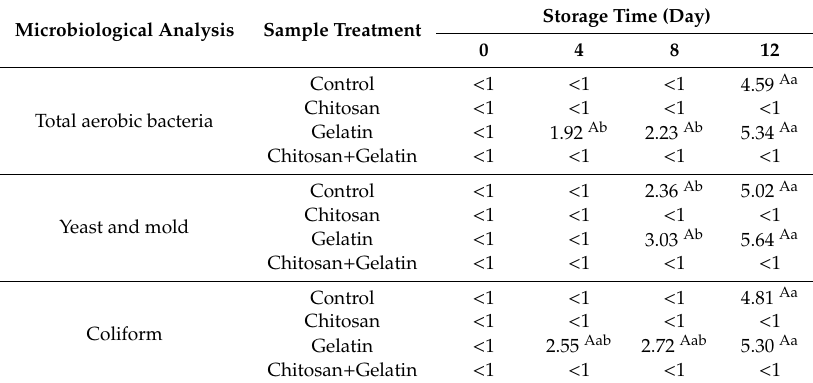
Table 5. Change in the populations of total aerobic bacteria, yeast, mold, and coliform in fresh-cut apple slices stored 12 days at 5 ◦